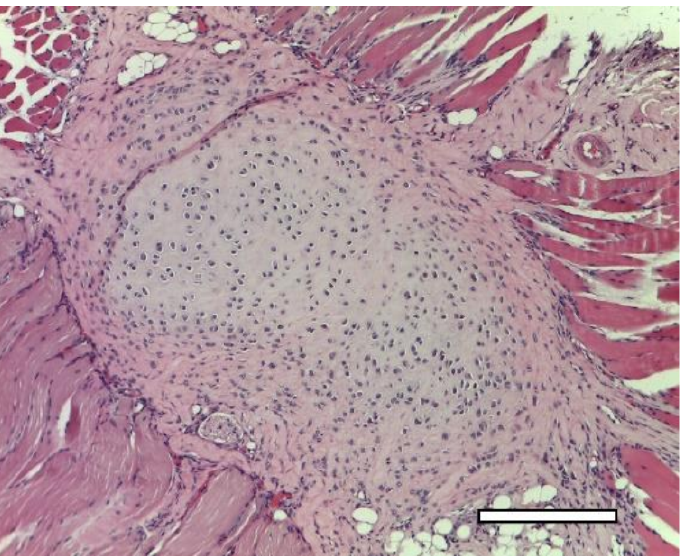
Figure 20. 3rd group (dECM and MSC), 2 weeks. Cartilage tissue in the muscles near the scaffold.